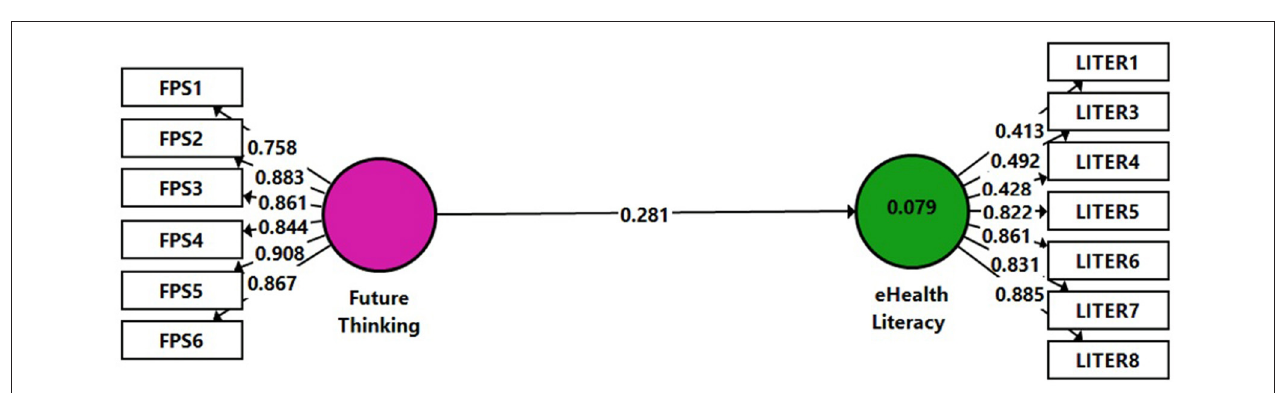
FIGURE 2 | Model 1. Analysis results of the examination of H2 by SmartPLS.